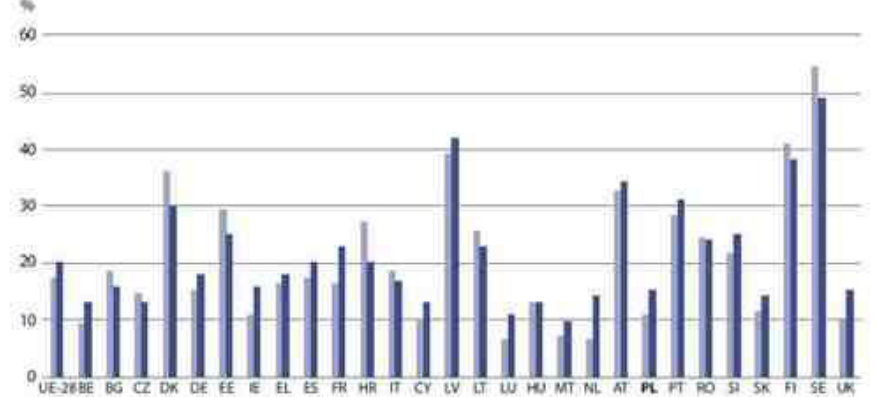
Figure 2. Share of energy from renewable sources, 2018. Source: Authors’ study based on Eurostat databases.